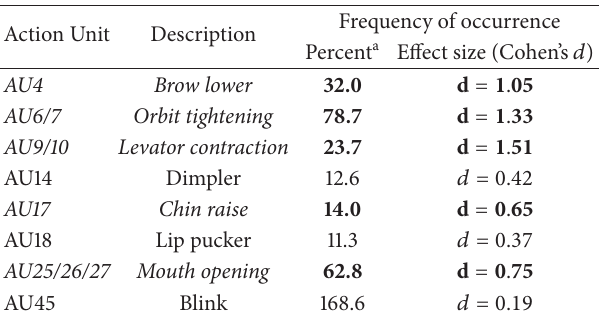
Table 1: Facial Action Units (AUs) with a critical frequency of occurrence of more than 5% in supra-NFR threshold trials. Effect sizes for frequency differences between “below threshold” and “suprathreshold” trials are